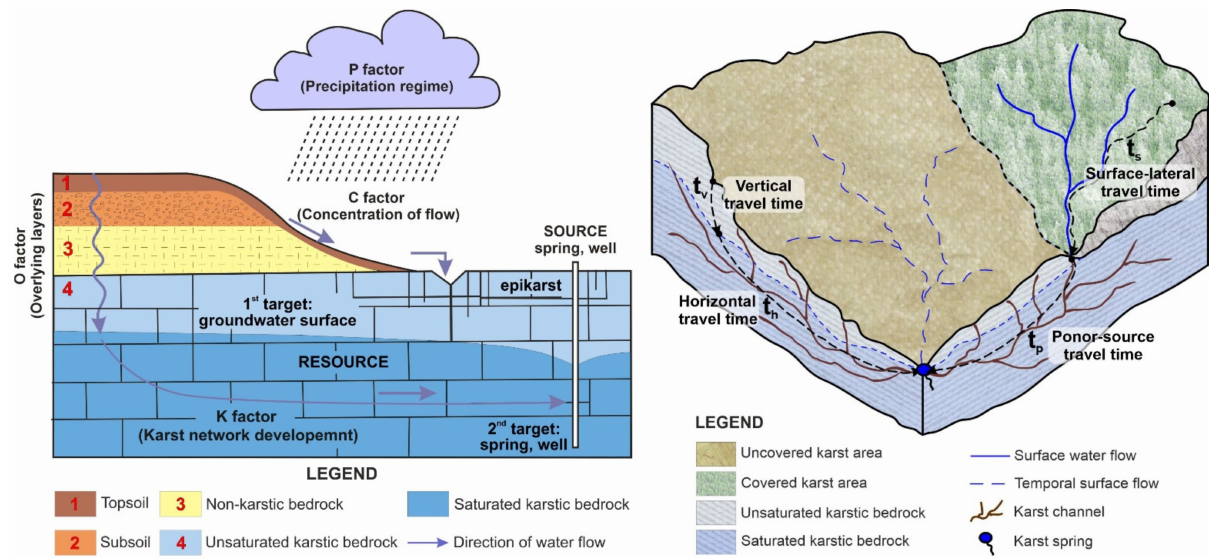
Figure 1. Conceptual model for vulnerability assessment using COP + K— left [28] and TDM method— right